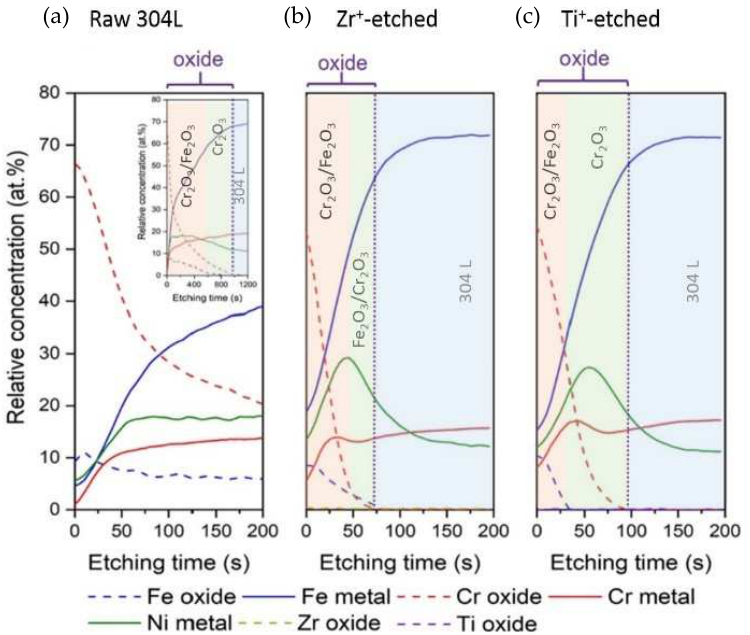
Figure 11. XPS depth profiles of ( a ) raw 304L steel and ( b ) Zr + - and ( c ) Ti + -etched samples after 48 h of immersion in nitric acid solution at boiling temperature.